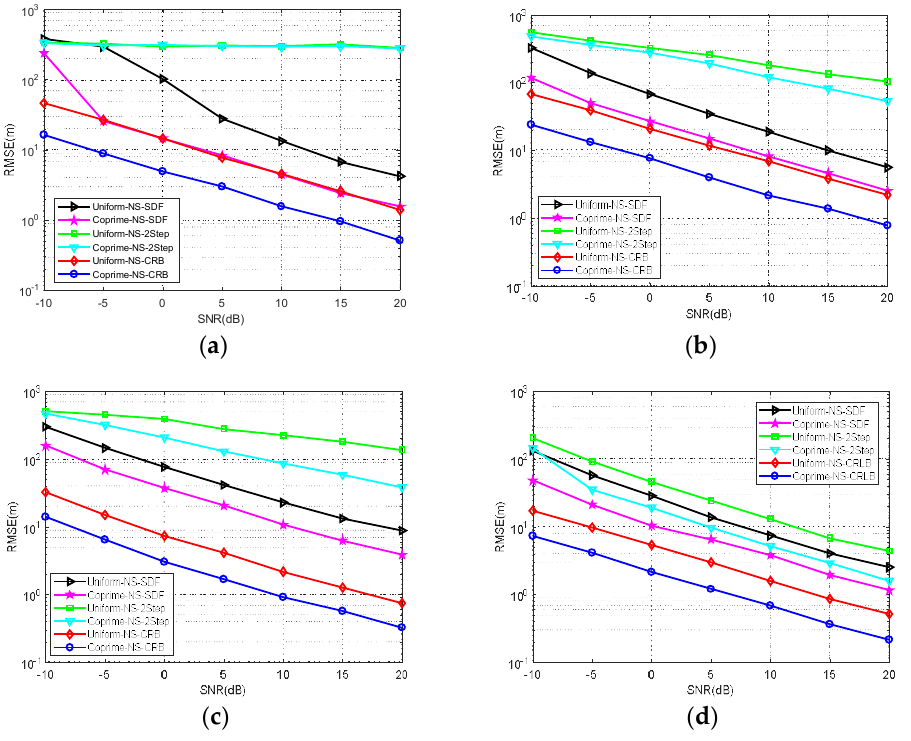
Figure 12. RMSE comparison under the four trajectories shown in Figure 11. ( a ) under the trajectory around the target sources ( b ) under the trajectory on one side of the target sources. ( c ) under the trajectory along the axis of the target sources ( d ) under one of the arbitrary movement trajectories. Simulation 5. RMSE comparison of MCA-DPD, SDF, two-step localization, and the CRLB for different modulation